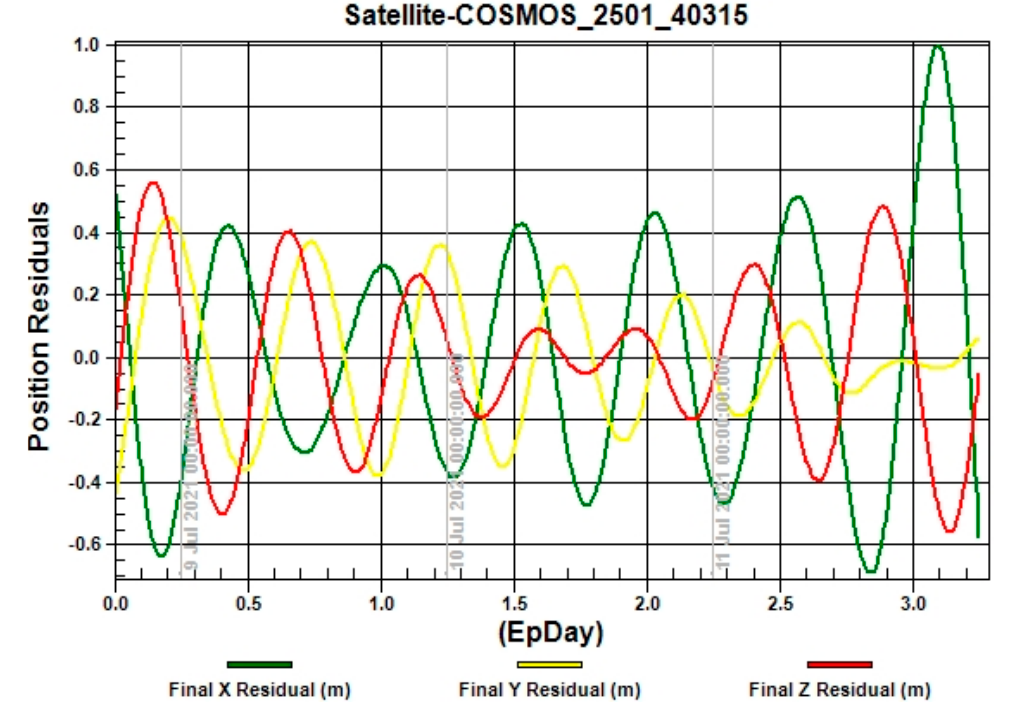
Figure 6. The relationship between the position residuals and the time for satellite “COSMOS- 2434”.